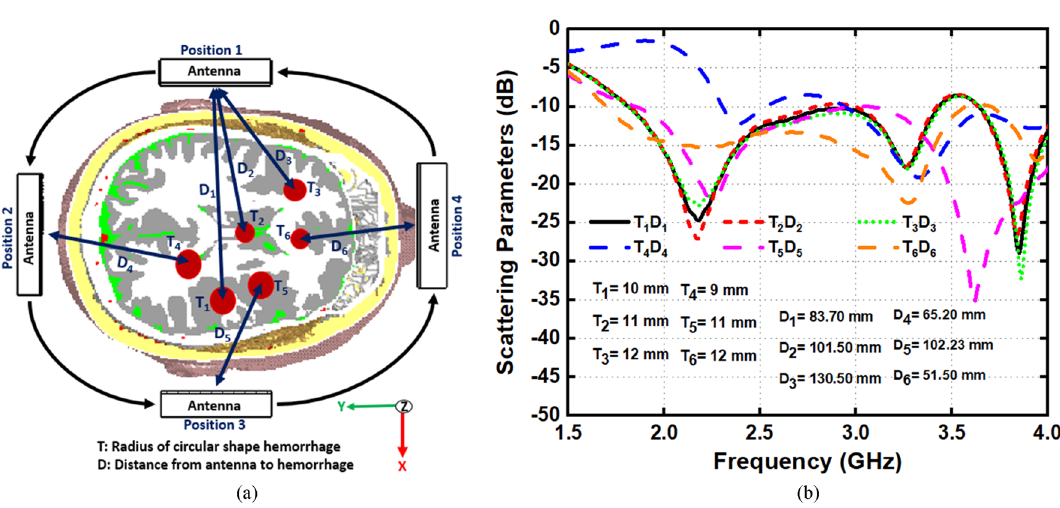
Figure 10. ( a ) Different antenna position with different size and location of hemorrhages and ( b ) scattering